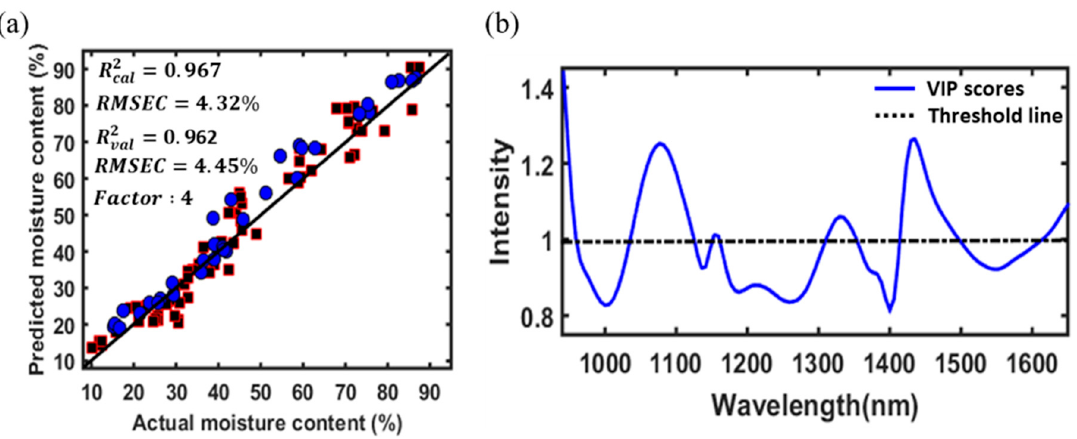
Figure 7. Regression plot using the PLSR model for the calibration (squares) and validation (circles) sets developed with variable importance in projection (VIP) selected variables ( a ), and VIP score plot calculated determined using the PLSR model ( b ).